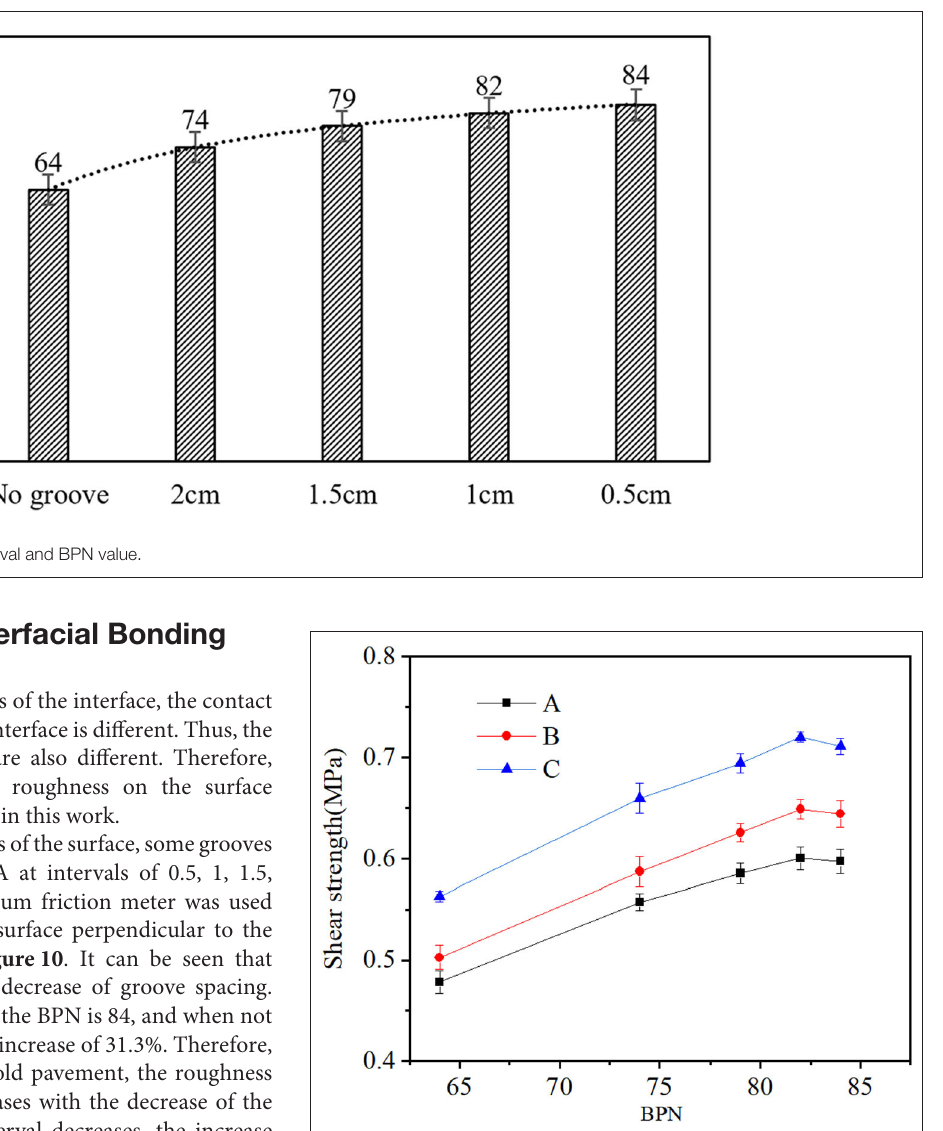
FIGURE 11 | Interfacial shear strength at different surface